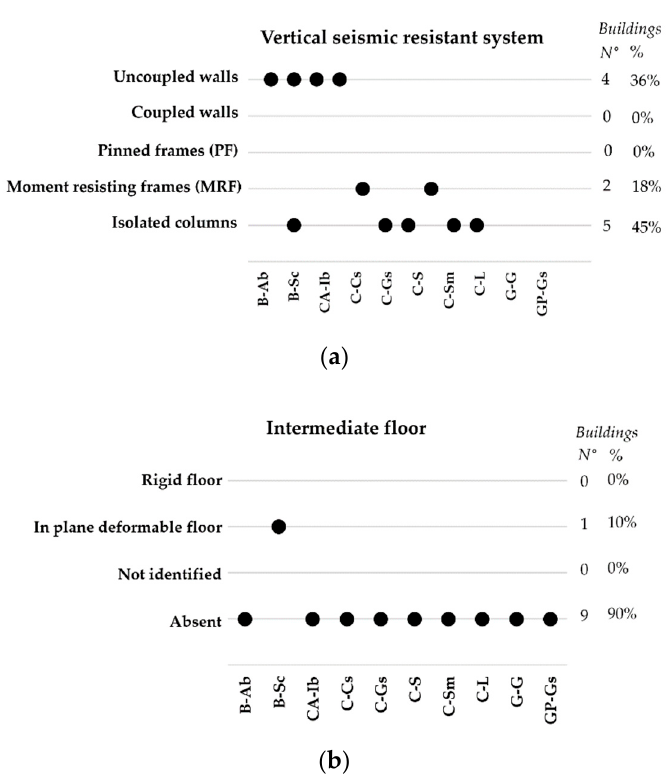
Figure 13. Section 1B CARTIS-Building. Vertical structural system and relationship with intermediate floors: ( a ) Vertical seismic-resistant structure; ( b ) Intermediate floor.